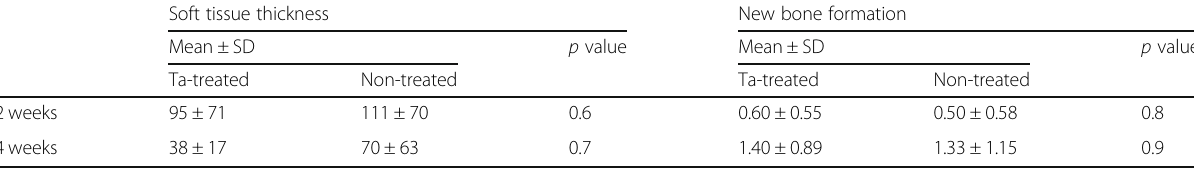
Table 3 Soft tissue thickness in the ePTFE implant materials Soft tissue